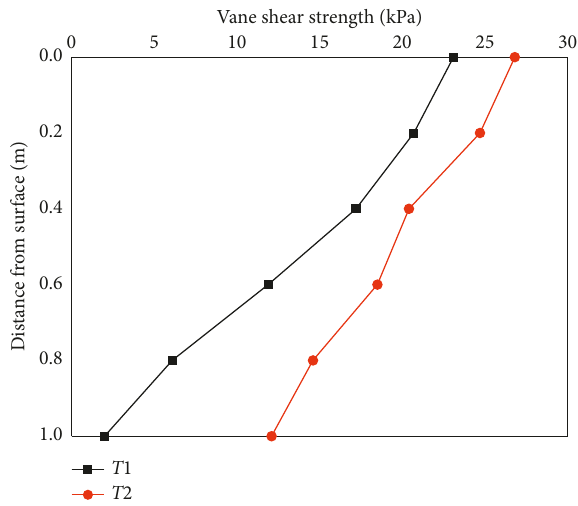
Figure 8: Variations in the vane shear strength with the soil depth plotted for cylinders T 1 and T